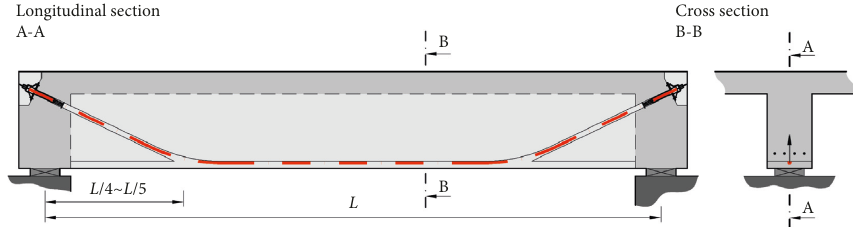
Figure 1: The basic scheme of cable arrangement in the case of strengthening a simple span bridge by post-tensioning using the substitute cable duct method.